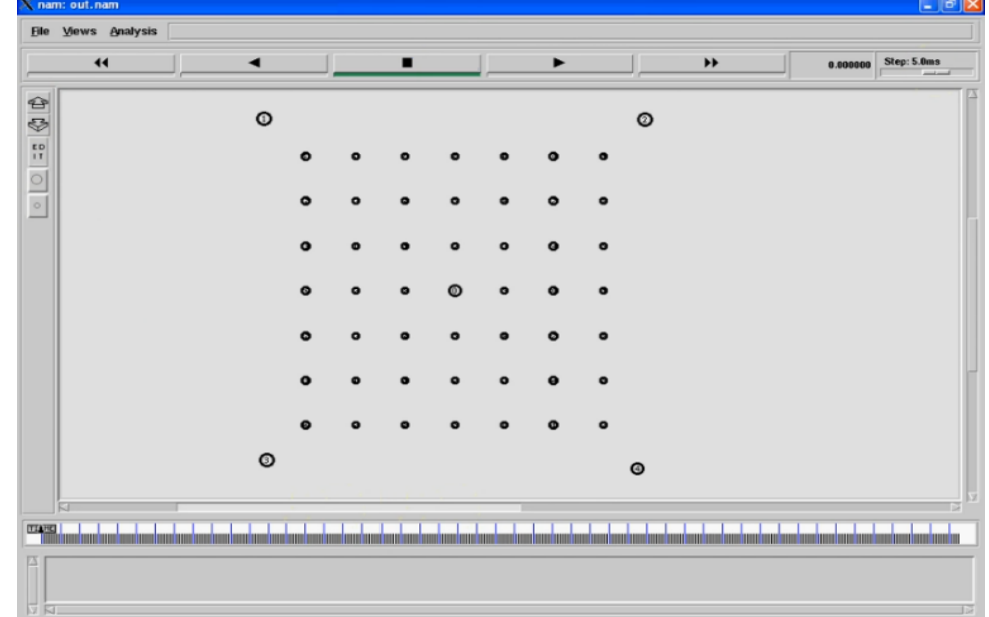
Figure 3. Network Grid with 49 nodes (7 × 7) matrix